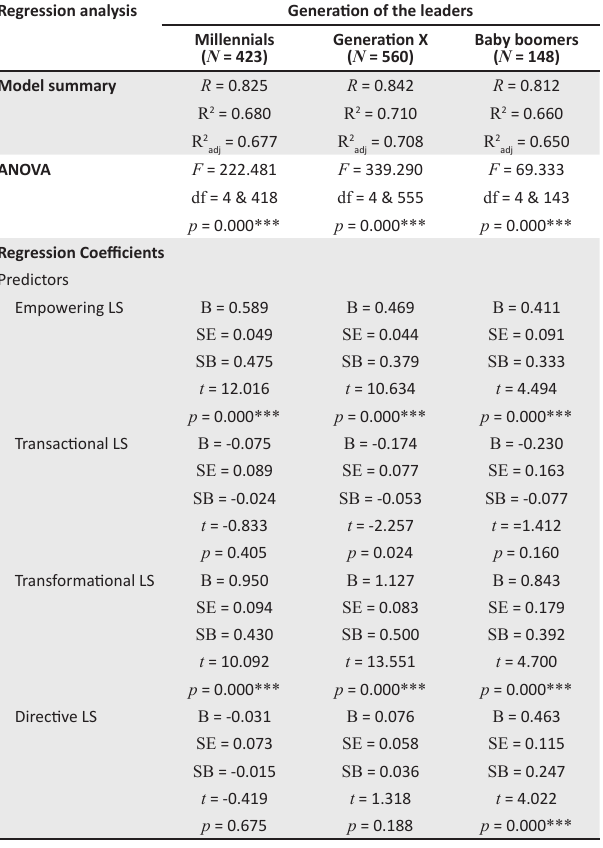
TABLE 7: Model summary, ANOVA, and coefficients for leadership styles predicting leader effectiveness, given the generation of the leaders (the actors). Regression